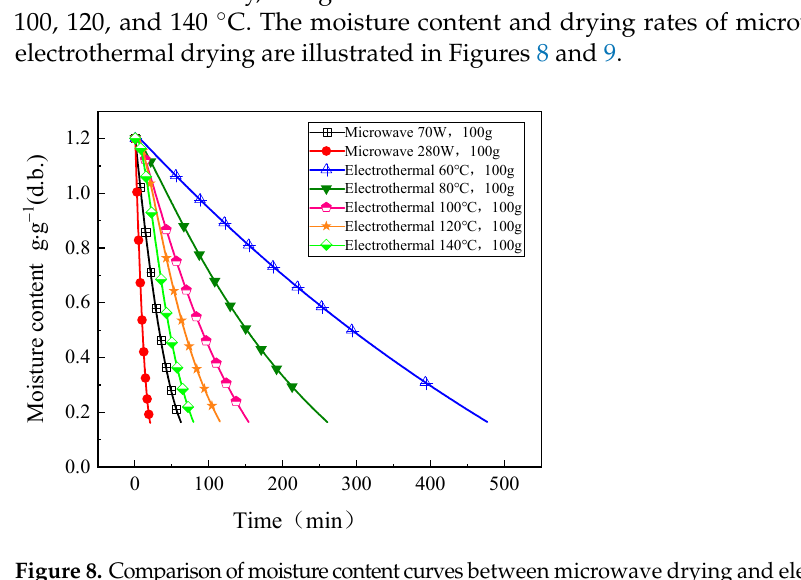
Figure 9. Comparison of drying rate between microwave drying and electrothermal drying. Figures 8 and 9 show that microwave drying is much faster than electrothermal dry ‐ ing. Even if electrothermal drying is performed at a high temperature of 140 °C, it takes 78 min, which is 1.13 and 3.55 times longer than drying under microwave powers of 70 W and 280 W. Its maximum drying rate is 2.31 × 10 − 2 g/g ∙ min − 1 (d.b.), which is 0.92 and 0.23 times that of the maximum rate during microwave drying at 70 W and 280 W, respectively. This is mainly because during microwave drying, the internal temperature of the materi ‐ als is high and the direction of heat conduction is consistent with that of moisture diffu ‐ sion, which is conducive to moisture evaporation [15,23]. The energy consumptions using different drying methods are shown in Table 4. As shown in Table 4, microwave drying has obvious energy ‐ saving effects. The energy con ‐ sumption during microwave drying at 70 W is 0.108, 0.186, 0.113, 0.090, and 0.093 times that of electrothermal drying at 60, 80, 100, 120, and 140 °C, respectively. The average power during microwave drying at 280 W is close to that of electrothermal drying at 100 °C, while the latter is 6.80 times that of the former in terms of energy consumption. Chua [6] and Pratap Singh [18] also obtained similar results. The main reason is that micro ‐ waves only act on polar molecules, so the heating efficiency is increased, and the energy loss is lower [33,34].